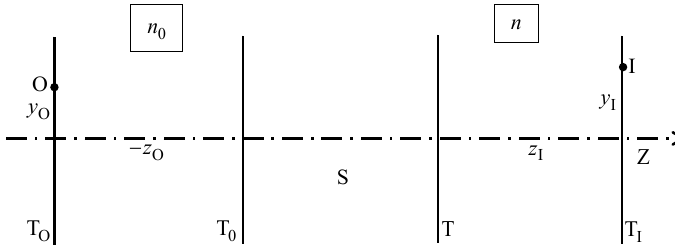
Figure 2 An object point O forms an image point I through a Gaussian system